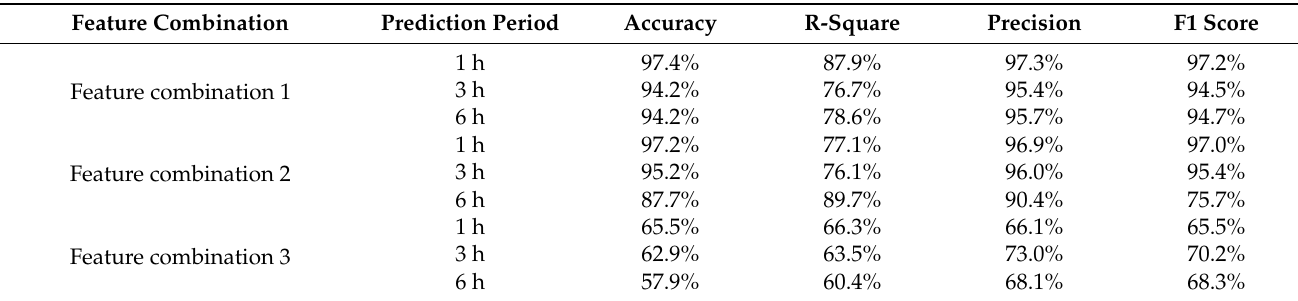
Table 8. Performance evaluation results of different prediction periods.